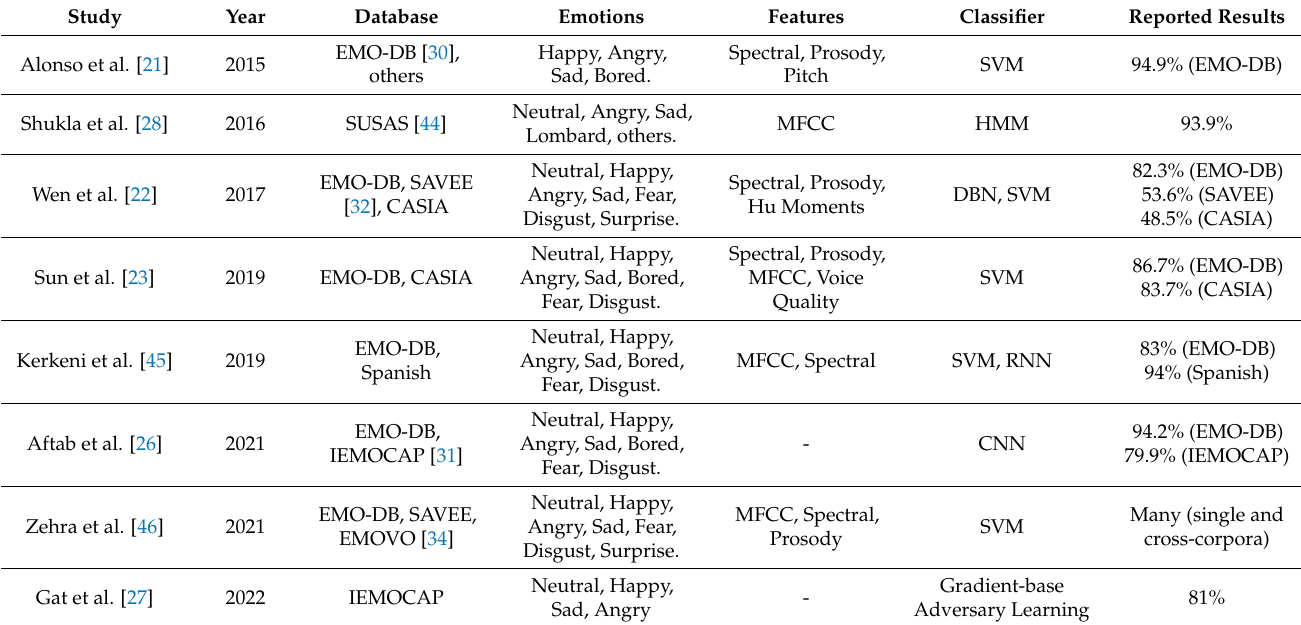
Table 1. Review of the most representative works in SER and the classifiers they